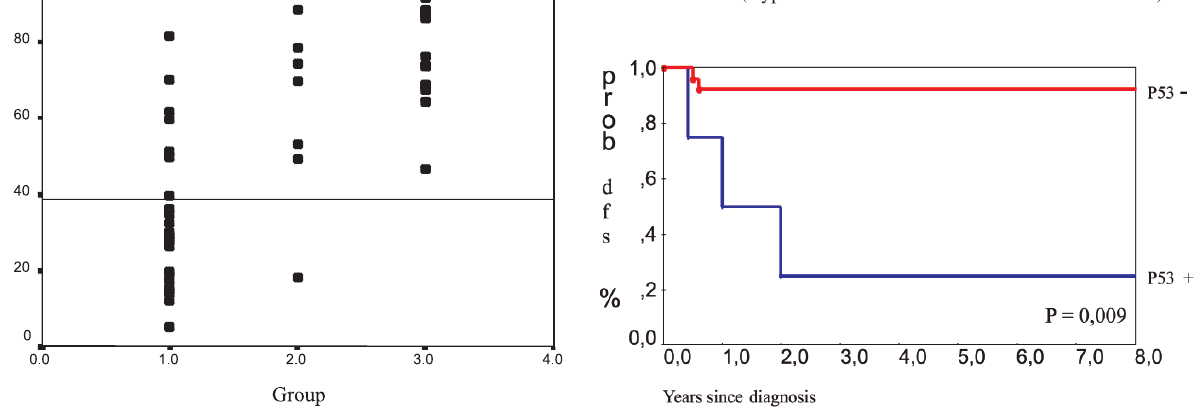
Figure 10 - PCNA% in classical osteoblastomas (1.0), atypical osteoblastomas (2.0), and osteosarcomas (3.0)